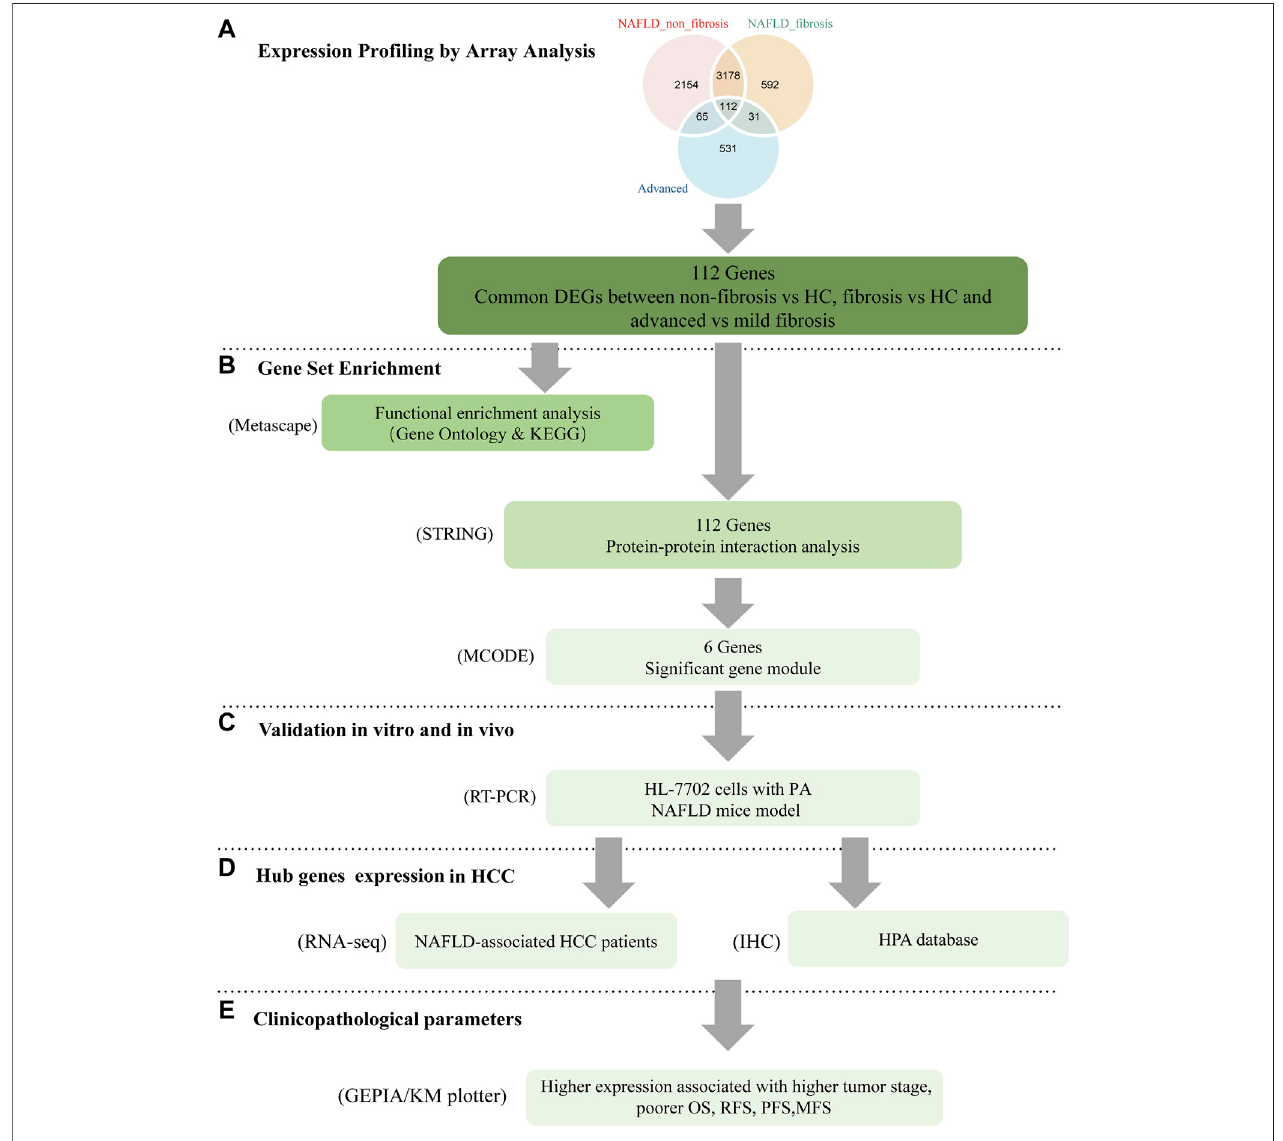
FIGURE 1 | Work fl ow of the present study. (A) common DEGs between non- fi brosis vs HC, fi brosis vs HC and advanced vs mild fi brosis were identi fi ed by integrated bioinformatics analysis. (B) Enrichment analysis was carried by the Metascape online database. The hub genes were attained by PPI with STRING and MCODE with cytoscape. (C) The expression of key genes was veri fi ed by in vitro and in vivo experiments. The function of NUSAP1 was con fi rmed by silencing assay. (D,E) Theexpression ofNUSAP1inhepatocellular carcinoma and itsrelationshipwithprognosiswereexplored. DEGs,differentially expressed genes; HC, Healthy Control; FFA, free fatty acids; IHC, immunohistochemistry; HPA, The Human Protein Atlas.